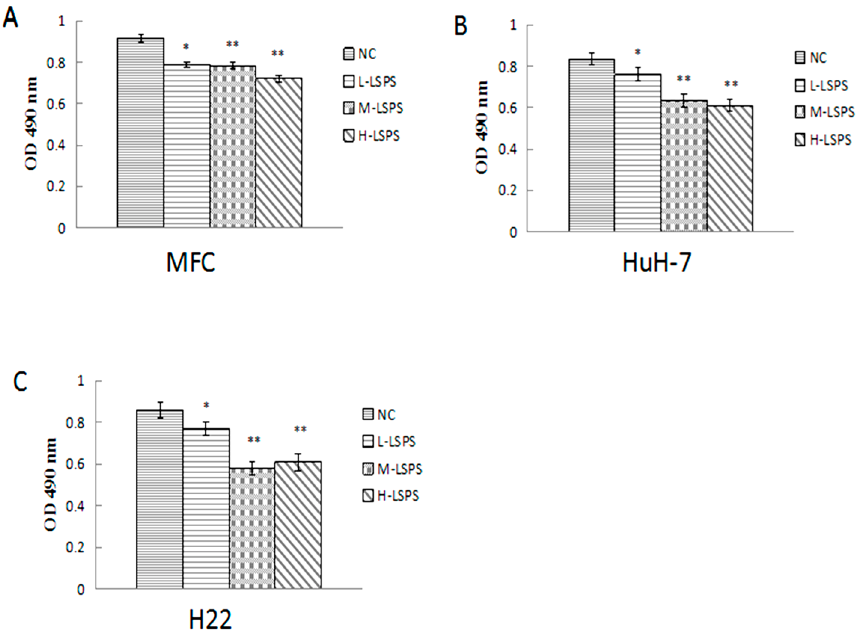
Figure 2. Inhibitory effect of LSPS on MFC ( A ); HuH-7 ( B ) and H22 ( C ) cells. The OD values are represented as means ± SD. Compared with negative control (NC), * p < 0.05, ** p < 0.01. L-LSPS, incubated with lotus seed polysaccharide solution (50 μ g/mL); M-LSPS, incubated with lotus seed polysaccharide solution (100 μ g/mL); H-LSPS, incubated with lotus seed polysaccharide solution (200 μ g/mL).